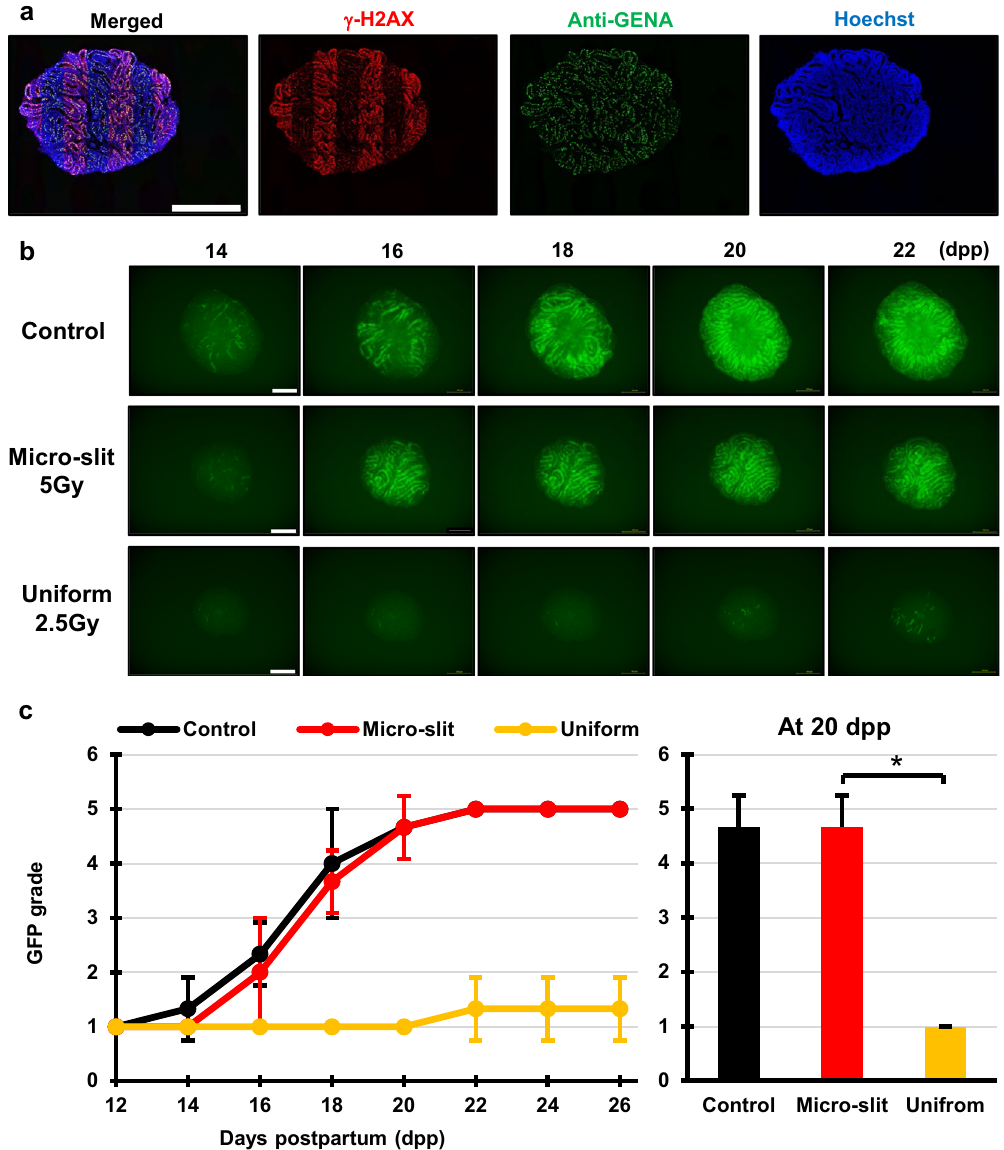
Figure 3. Tissue-sparing effect of micro-slit radiation in spermatogenesis. ( a ) Immunohistochemical images of ex vivo testes culture tissues 1 h after 10 Gy 200 μ m-slit X-ray microbeam irradiation. Staining for γ -H2AX, Anti-GENA (anti-germ cell-specific antigen antibody), and Hoechst (for DNA) is shown as red, green, and blue, respectively. Scale bars, 500 μ m. ( b ) Representative images show Acr-GFP expression changes in single cultures following 0 Gy (control), 5 Gy micro-slit (50%), and 2.5 Gy uniform (100%) X-ray irradiation, from 14 to 22 days postpartum (dpp). Scale bars, 500 μ m. ( c ) Chronological changes in Acr-GFP expression after the micro- slit and the uniform X-ray irradiation. A minimum of three tissue samples each from different donor mice were used for each experiment. Data represent the mean GFP expression ± SD. Asterisk indicates P <